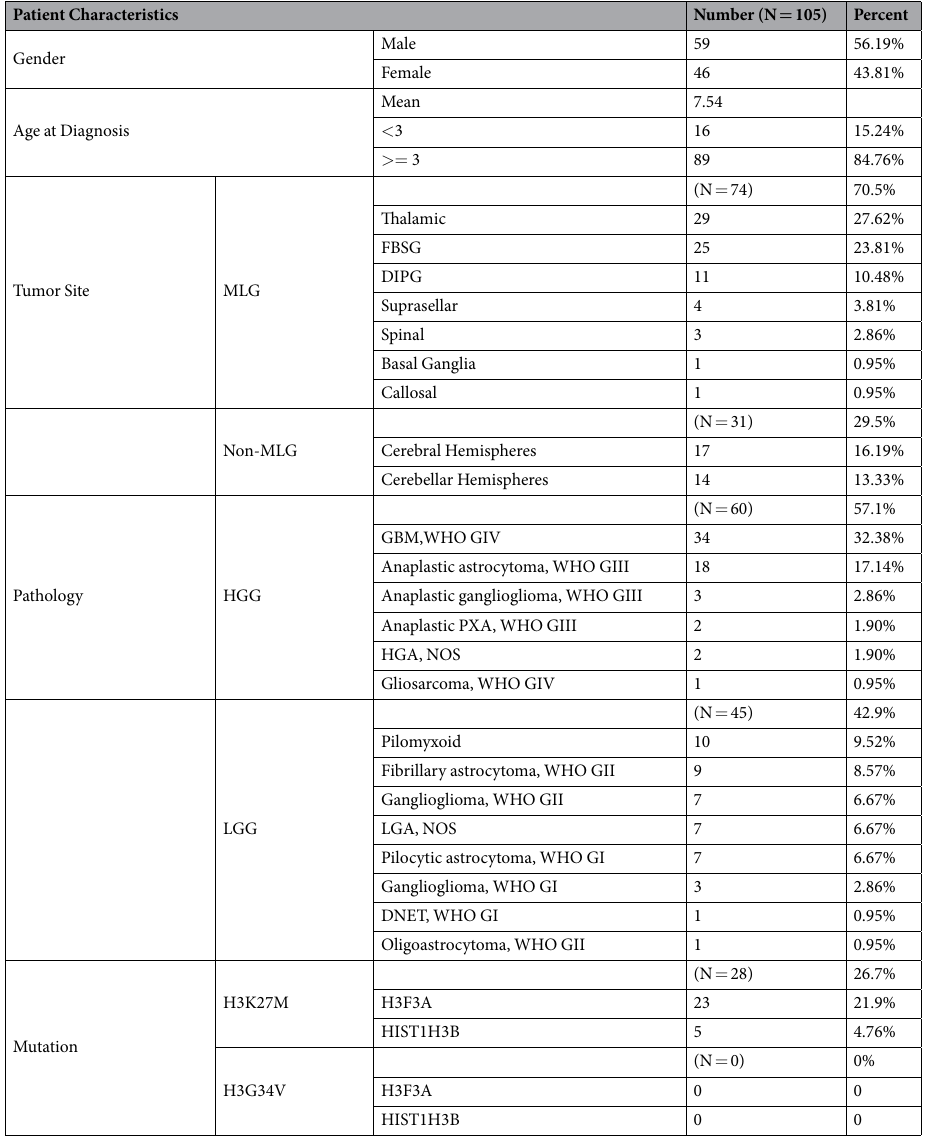
Table 1. Summary of patients’ clinicopathological